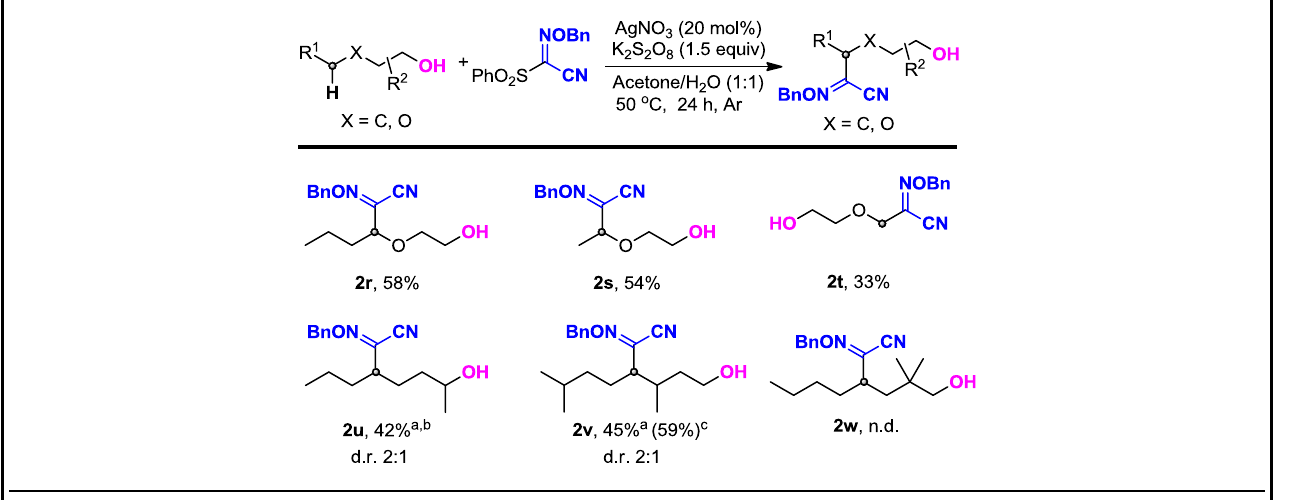
Table 3 AgNO 3 -catalyzed δ -selective functionalization of substituted alkanols